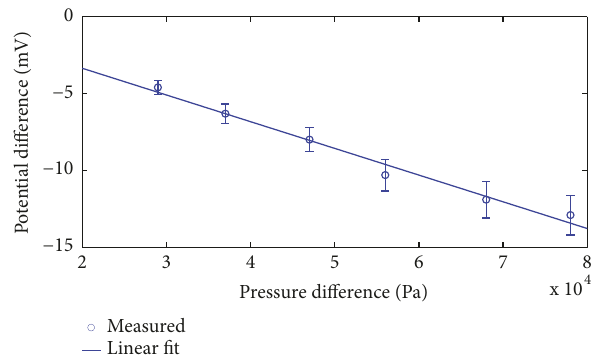
Figure 7: Streaming potential as a function of pressure difference for the 32.1% mass fraction at 10 ∘ C. The symbols are the measured data. The solid line is the linear fit.